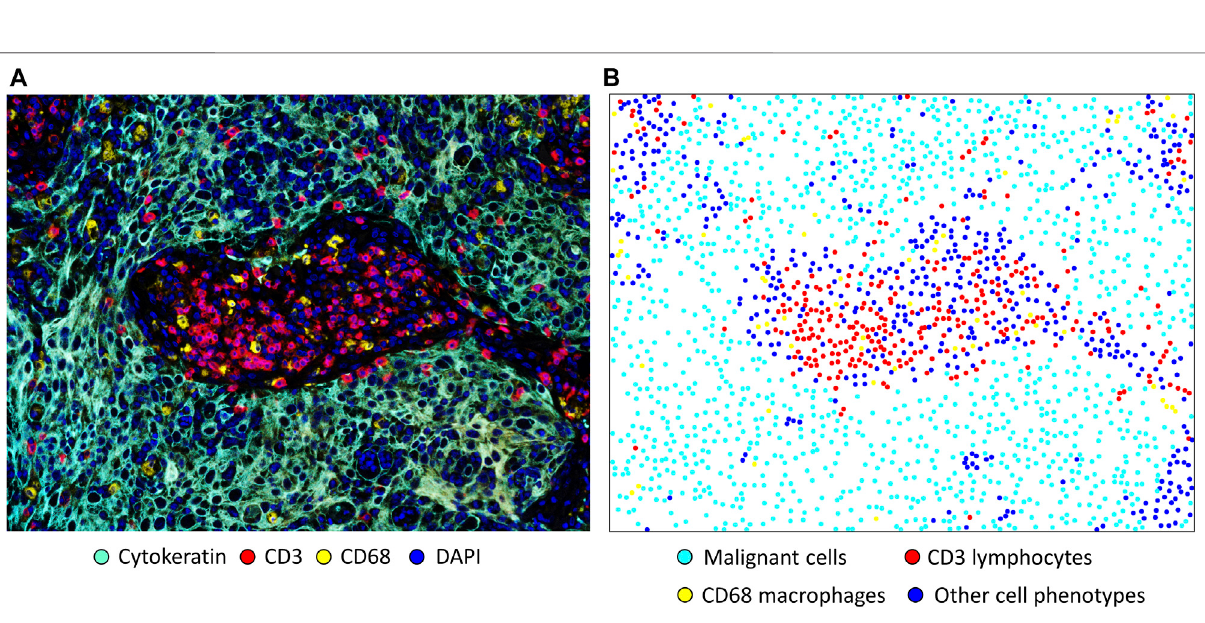
Frontiers in Molecular Biosciences |